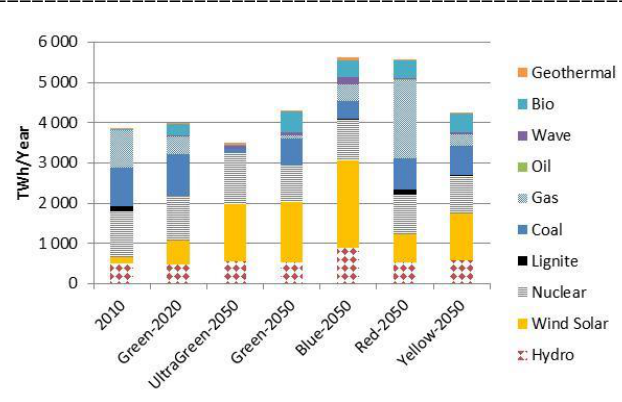
Fig. 5. Production portfolios for each scenario in 2050. The development of shares of renewables in electricity production (RES-E) in the different scenarios is shown in Figure 6. EU’s target of 20 % RES in the final demand of energy in 2020 implies about 35 % RES-E [28]. If we assume similar RES-E targets for 2020, the EU targets are achieved for all the scenarios except Red. The share of RES-E in Green 2020 is 35 %. The shares of RES-E in 2050 are similar in the Blue (69.3 %) and the Green (63.7 %) scenarios in spite of very different production portfolios. The volume of RES-E production is much higher in Blue (2 844 TWh/y) in 2050 than in the Green scenario (2 108 TWh/y), but the demand is also much higher. The Yellow scenario ends up between the Red and the Green. Limitations in new technologies result in the curve flatting out in the Yellow scenario.